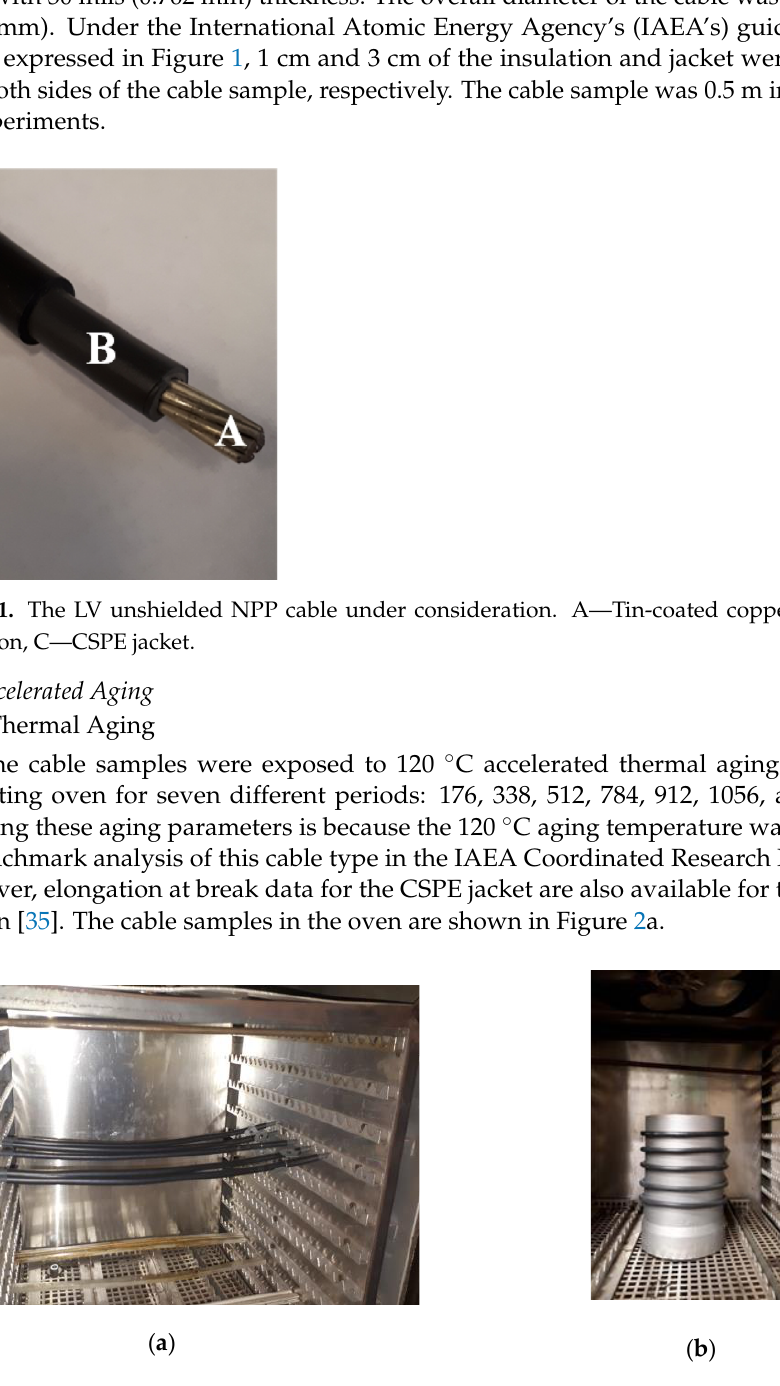
Figure 1. NPP LV Unshielded Cable under consideration 96